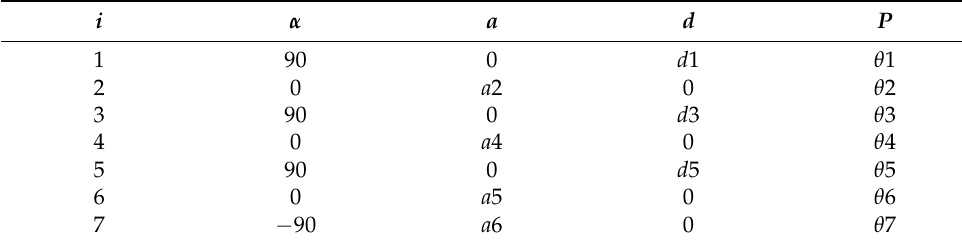
Figure 8. Denavit&Hartenberg Convention. Table 2. RM Cyton 1500 D&H